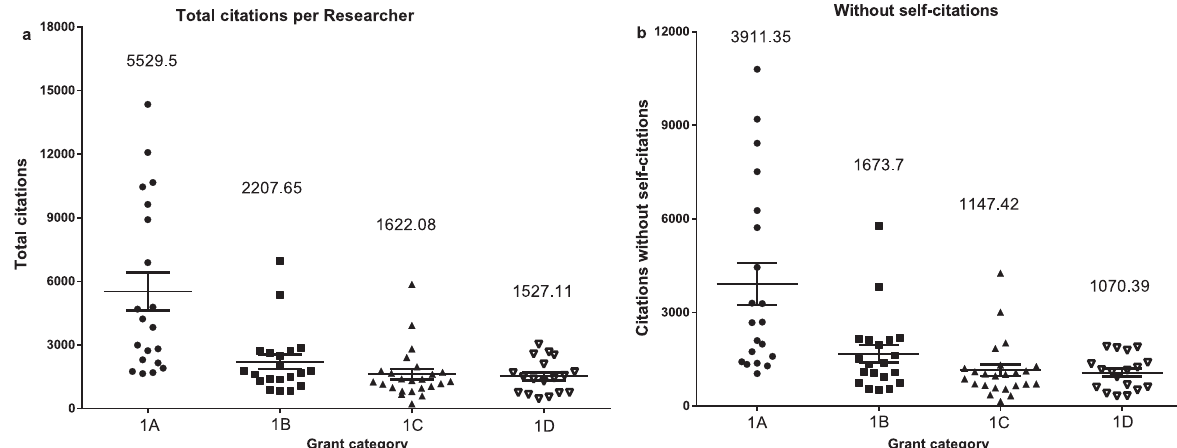
Figure 2 - Distribution of the total citations with (a) and without self-citations (b) of Brazilian researchers from CNPq grant category 1A-D in Pharmacology. The numbers above indicate the mean of citations per